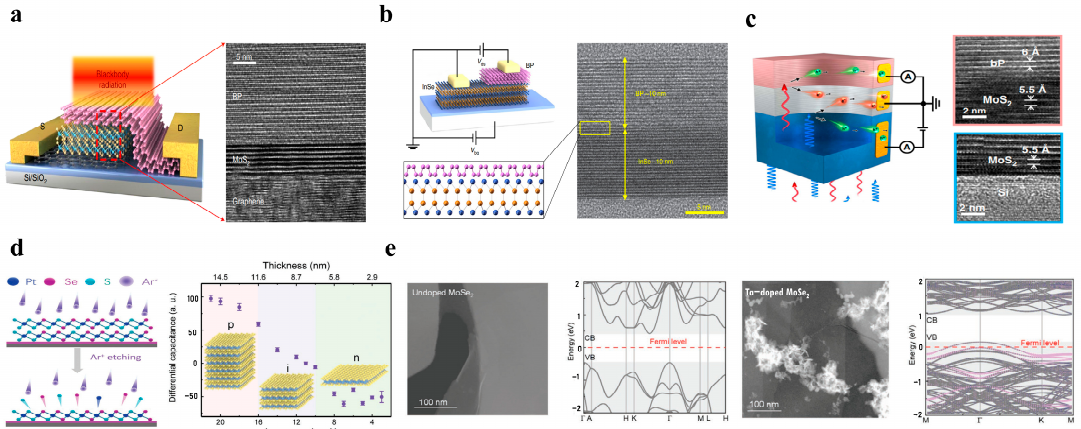
Figure 1. Physical properties comparison of 2D materials and 3D materials. ( a ) Bandgap comparison of 2D materials and 3D materials and spectral radiance for di ff erent temperature sources [17,54–60]. ( b ) Thickness-normalized EQE for di ff erent materials: the sca tt er represents the 2D-layered materi- als, while the line represents traditional thin fi lm materials [17,45,61–71]. (Hollow symbol represents measured results of laser source, and solid symbol and solid lines represent the result of blackbody source.) ( c ) Comparison of carrier mobility in different crystal system. Graphene and HgCdTe exhibit ultra-high carrier mobility, orthorhombic BP, PdSe 2 and triclinic ReSe 2 , ReS 2 exhibit polarization- sensitive properties [57,72–80].